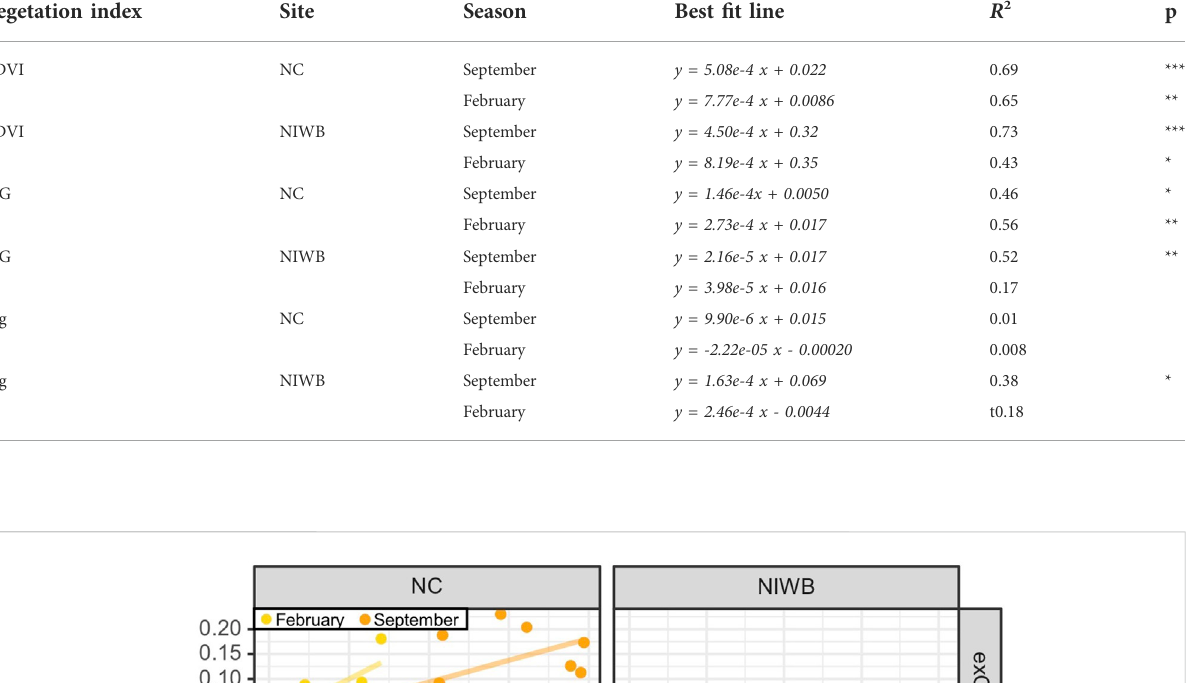
TABLE 3 Vegetation indices demonstrate signi fi cant relationships with ground-derived biomass measurements. Data represented are Pix4D- processed data using 50 m altitude fl ights in both February and September. ***: p < 0.001, **: p < 0.01, *: p < 0.05 Vegetation index